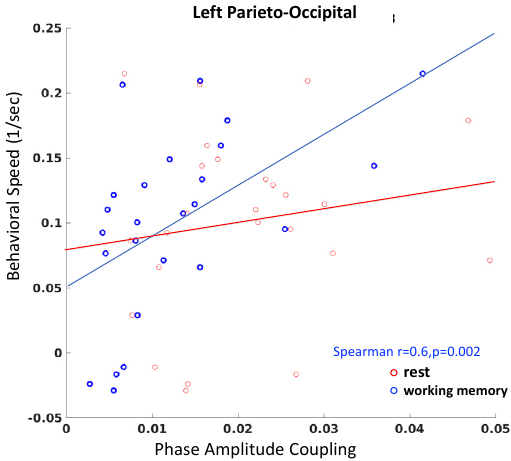
Figure 5. Phase amplitude gut ‐ brain coupling in four brain regions differs by cognitive state and gut satiety state. Significant cognitive state (resting versus working memory) based differences in PAC (marked with ^) are observed in the left fronto ‐ central (C3, F3), right fronto ‐ central (C4, F4), and left parieto ‐ occipital (P3, O1) regions. Modulations in the right parieto ‐ occipital (P4, O2) region were not significant. Specifically, the left fronto ‐ central region also showed significant (marked with #) hunger vs. satiety gut state effects, and significant cognitive state differences that vary with the levels of hunger (refer to Table 1 for statistical results).